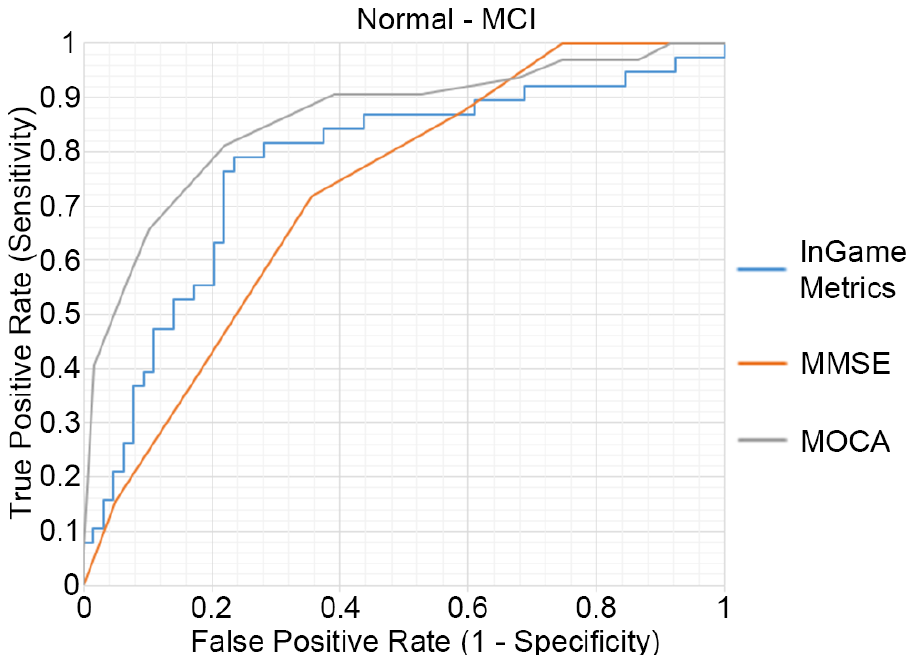
Figure 3. Receiver operating characteristic (ROC) curves of the HRMG metrics, MMSE and MOCA. MCI (n = 64) versus cognitively normal group (n = 38).